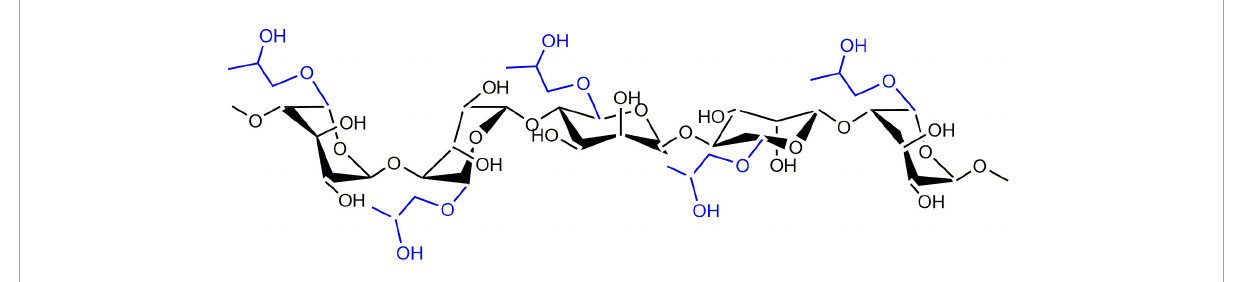
FIGURE1 Chemical structure of PGA